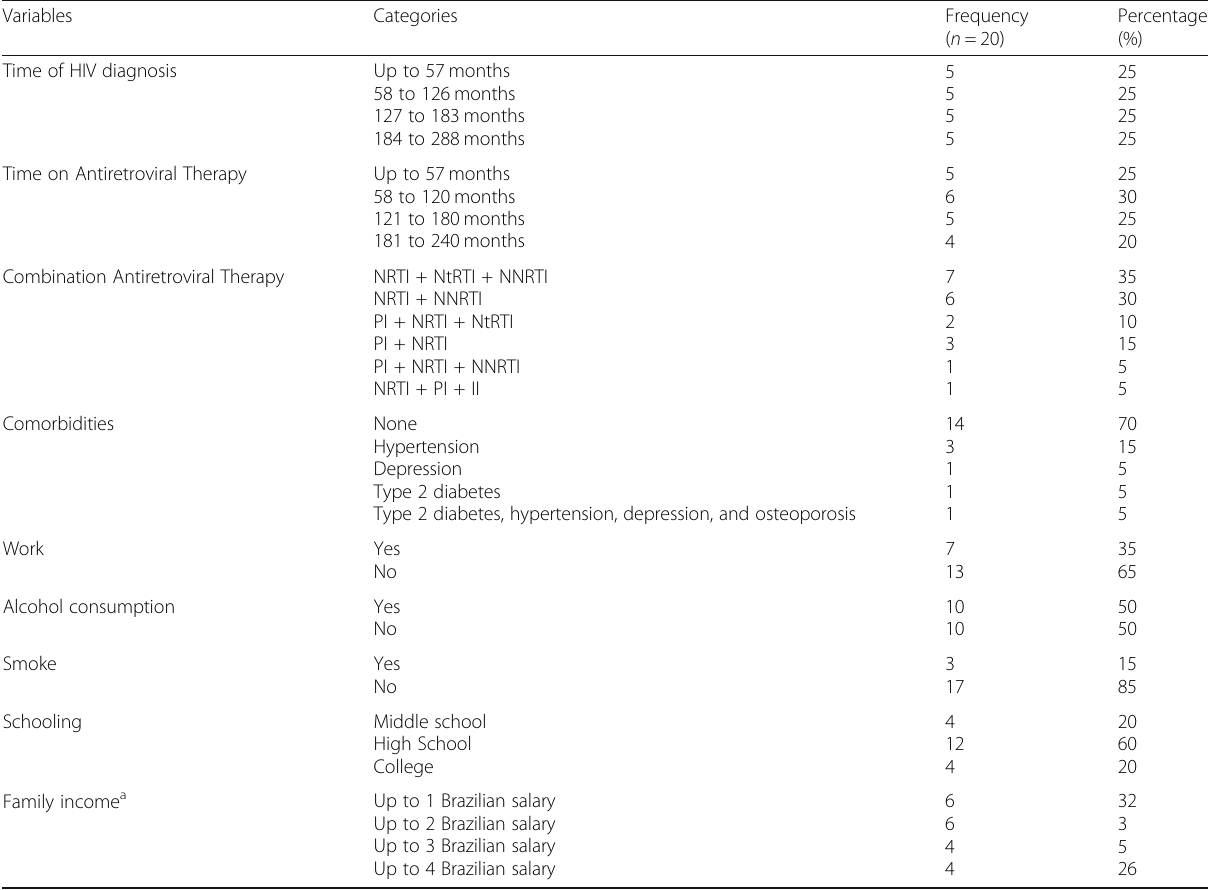
Table 1 Clinical and socioeconomic aspects of people living with HIV/AIDS